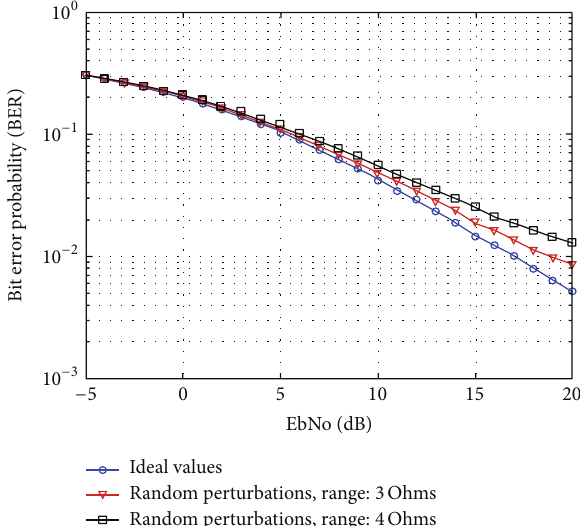
Figure 11: Bit error probability performance, under various loading conditions.